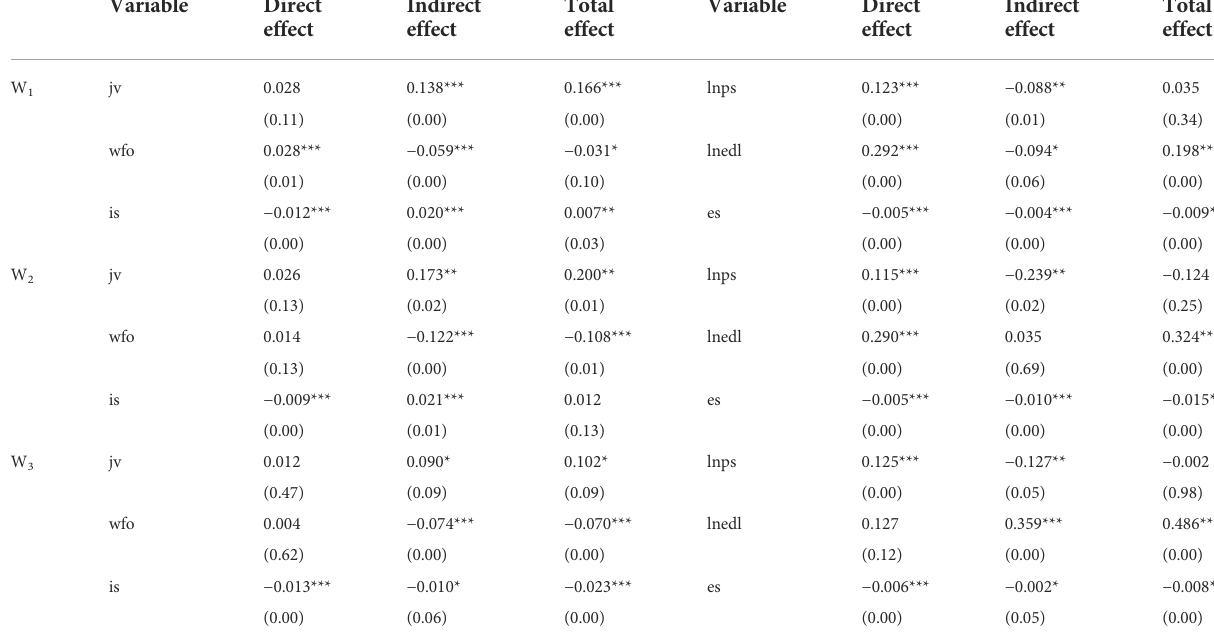
TABLE 6 Effect decomposition of spatial Durbin